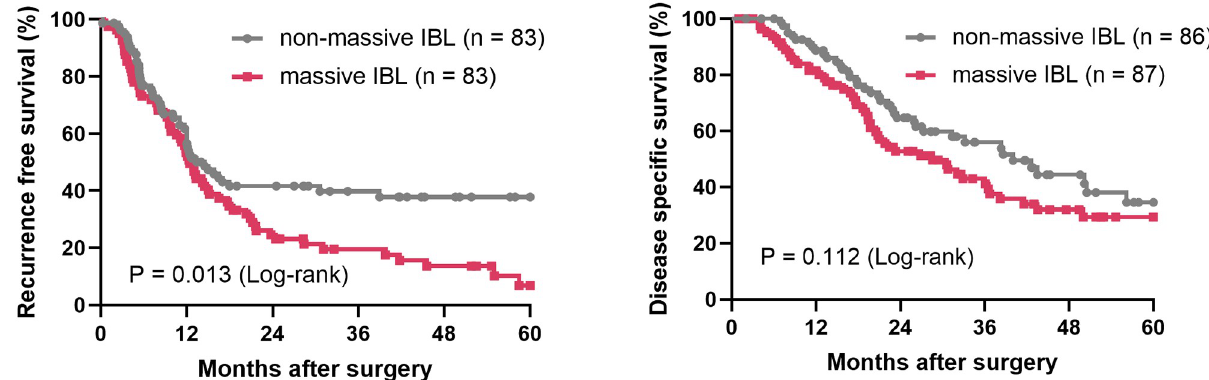
Fig 1. Survival curves of the massive IBL and non-massive IBL groups. IBL, intraoperative blood loss.